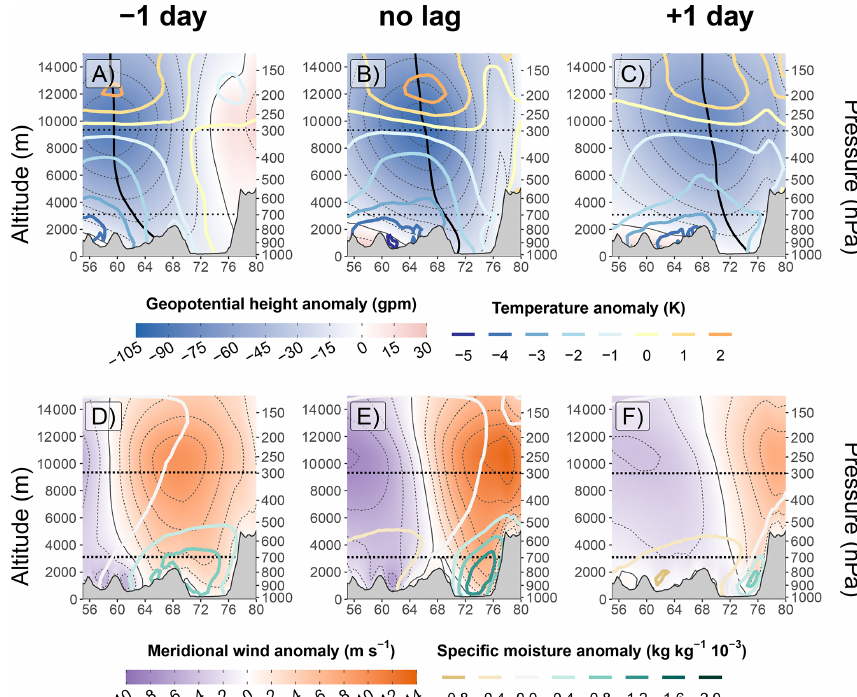
Figure 4. Composite cross-section along 30 ◦ N of the anomaly of geopotential height (colour shading, thin contour lines every 15gpm) and temperature (thick contour line) in panels (a) to (c) and meridional wind (colour shading, thin contour lines every 2ms − 1 ) and specific moisture (thick contour line) in panels (d) to (f) . Values are an average based on the 10% highest values of UV700 (b, e) . For panels (a) and (d) a 1d lead is applied to the selection, while a 1d lag is applied for panels (c) and (f) . The dotted horizontal lines represent the levels 700 and 300hPa, the altitudes for the cross-barrier moisture transport in Fig. 2 and minimum geopotential anomaly in Fig. 3, respectively. The thick vertical black line in (a) , (b) , and (c) represents the longitude of the minimum geopotential anomaly as a function of altitude. The grey shading represents the relief as in ERA5. Note that the mean meridional wind is close to 0 except near the relief over the Tibetan and Iranian plateaus, where valleys funnel the mean westerly